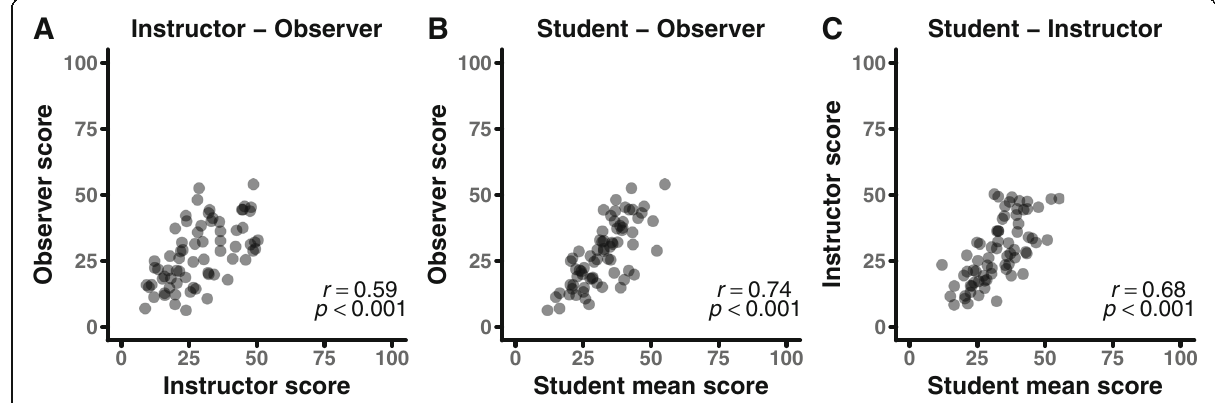
Fig. 2 Full MISTO score correlations between perspectives. Correlations between a instructor and observer scores, b student mean and observer scores, and c . student mean and instructor scores. Dots correspond to MISTO scores for each course; n = 70 total courses. MISTO scores can range from 0 to